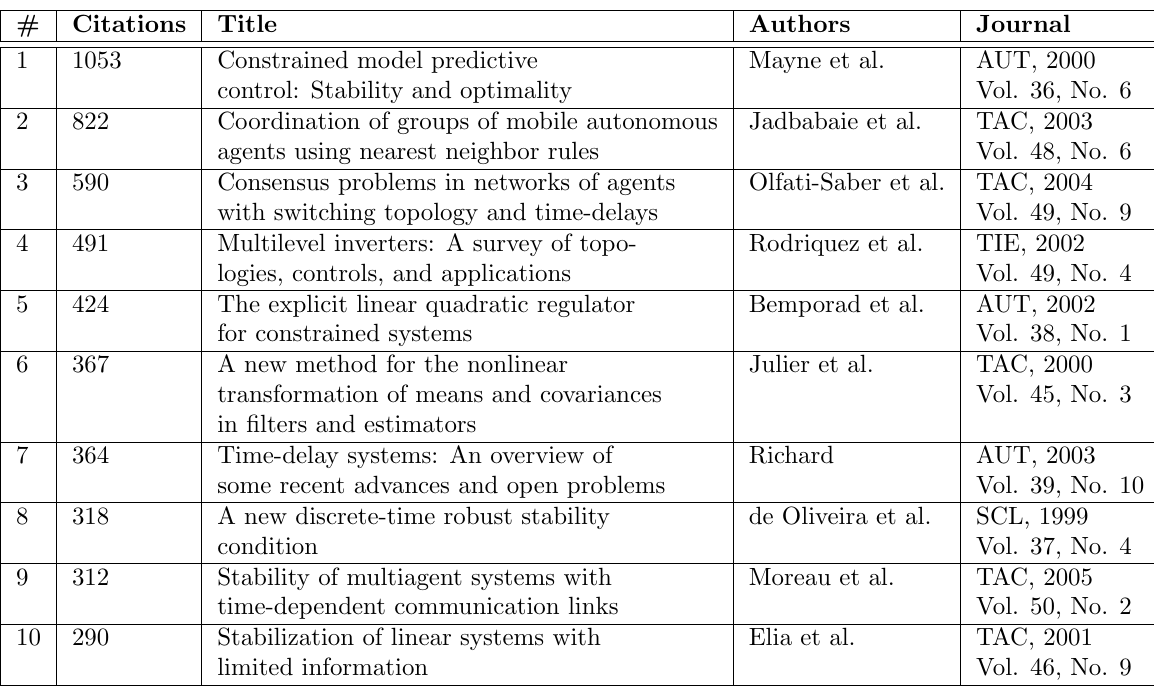
Table 2: Ranking of the highest cited papers (by ISI Web of Science on 17.11.2009) in the top 10 journals from Table 1 during the last decade. AUT=Automatica, TAC=IEEE Transactions on Automatic Control, SCL=Systems & Control Letters, TIE=IEEE Transactions on Industrial Electronics.